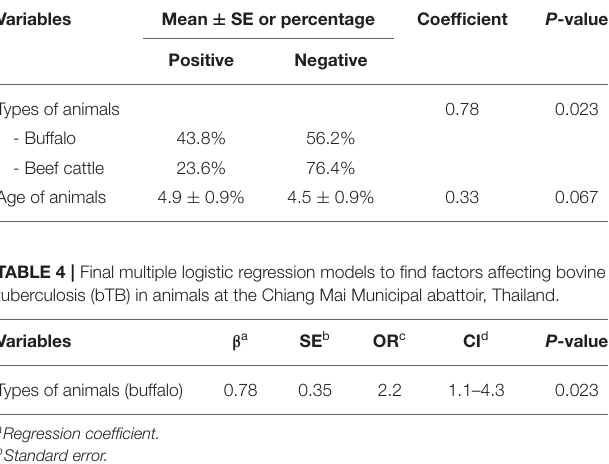
TABLE 2 | Cross-classified test results for bovine tuberculosis in 161 animals from meat inspection and polymerase chain reaction (PCR) tests. Diagnostic test results